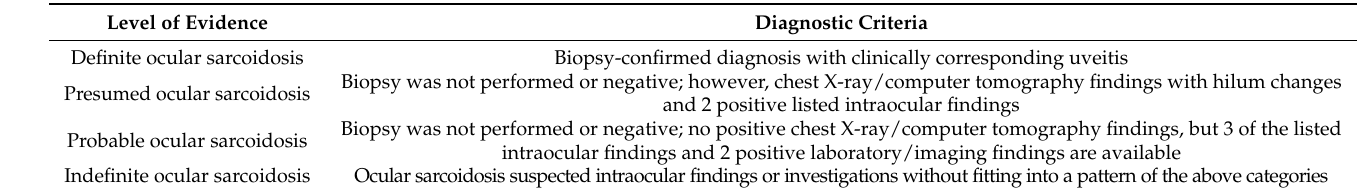
Table 2. Based on the International Workshop on Ocular Sarcoidosis diagnostic criteria, 4 levels of evidence for ocular sarcoidosis were derived (Adapted from